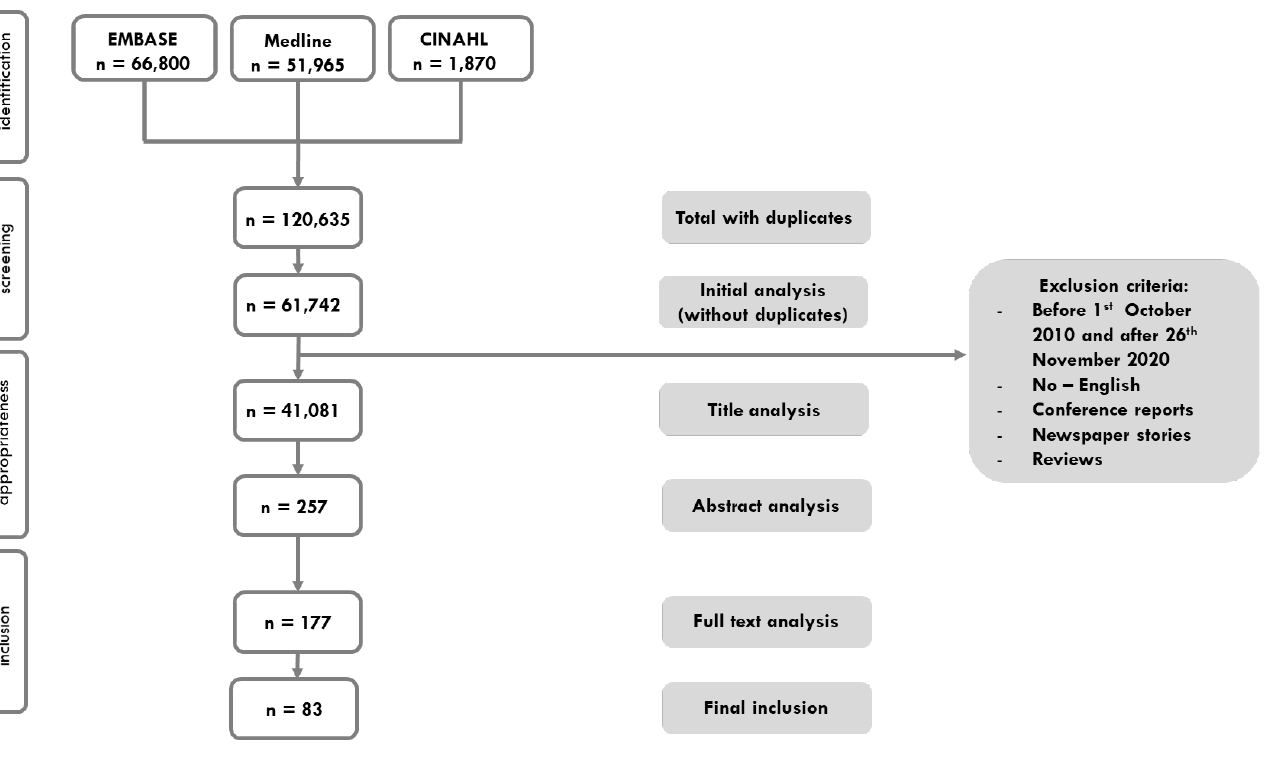
Figure 1. PRISMA flow diagram. Table 1. Adaptations to the definition of second victim (SV) based on the experts.